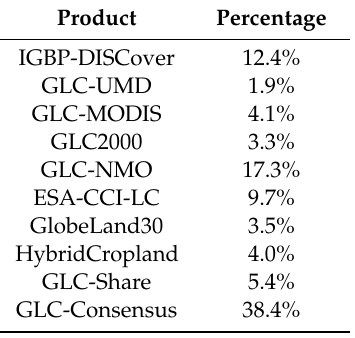
Table 3. The proportions of ten cropland datasets in the coincidence degree 1 of the overlay